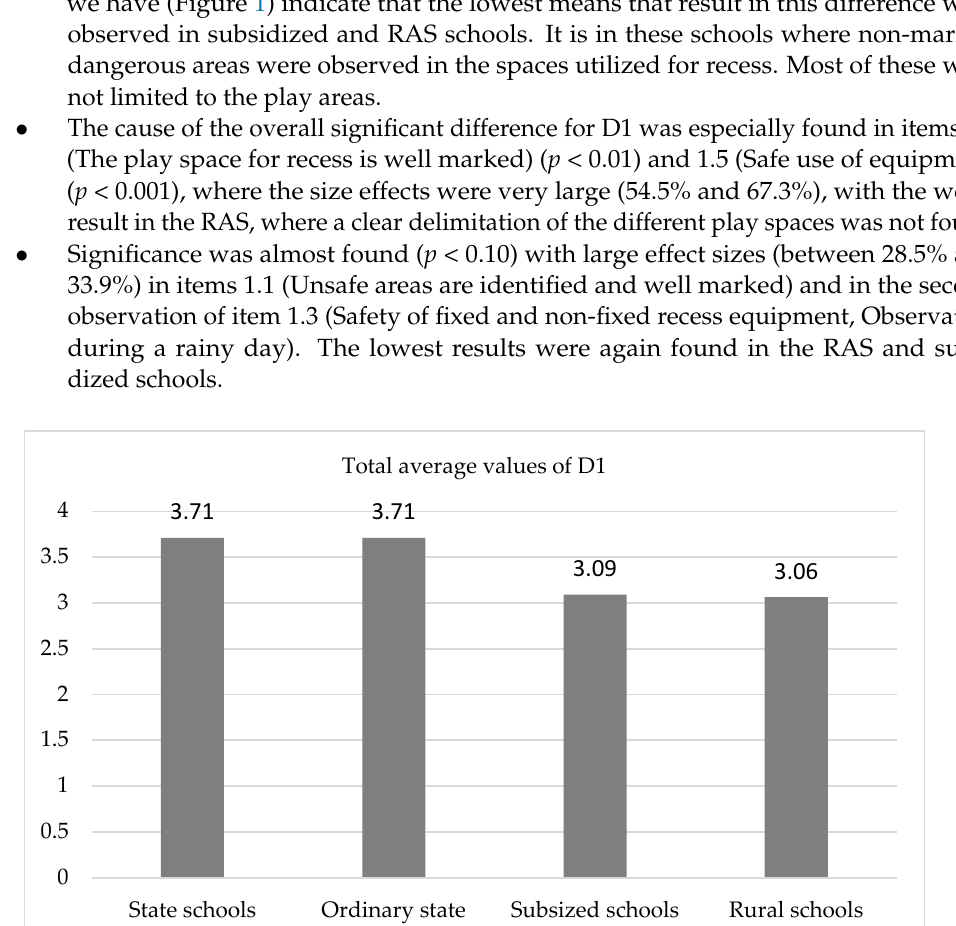
Table 3. Differences in means. Comparison of the significance of the differences in the variables from D1: Safety and structure as a function of school type. ( n = 23).